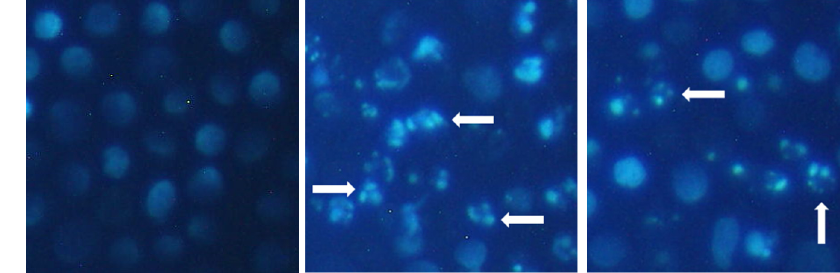
Figure 6. Morphology of HL-60 cells treated with cisplatin or 6 . HL-60 cells were stained with DAPI after treatment with either 20 μ M of cisplatin or 40 μ M of 6 for 24 h, and observed by a fluorescence microscopy (magnification: 200×).